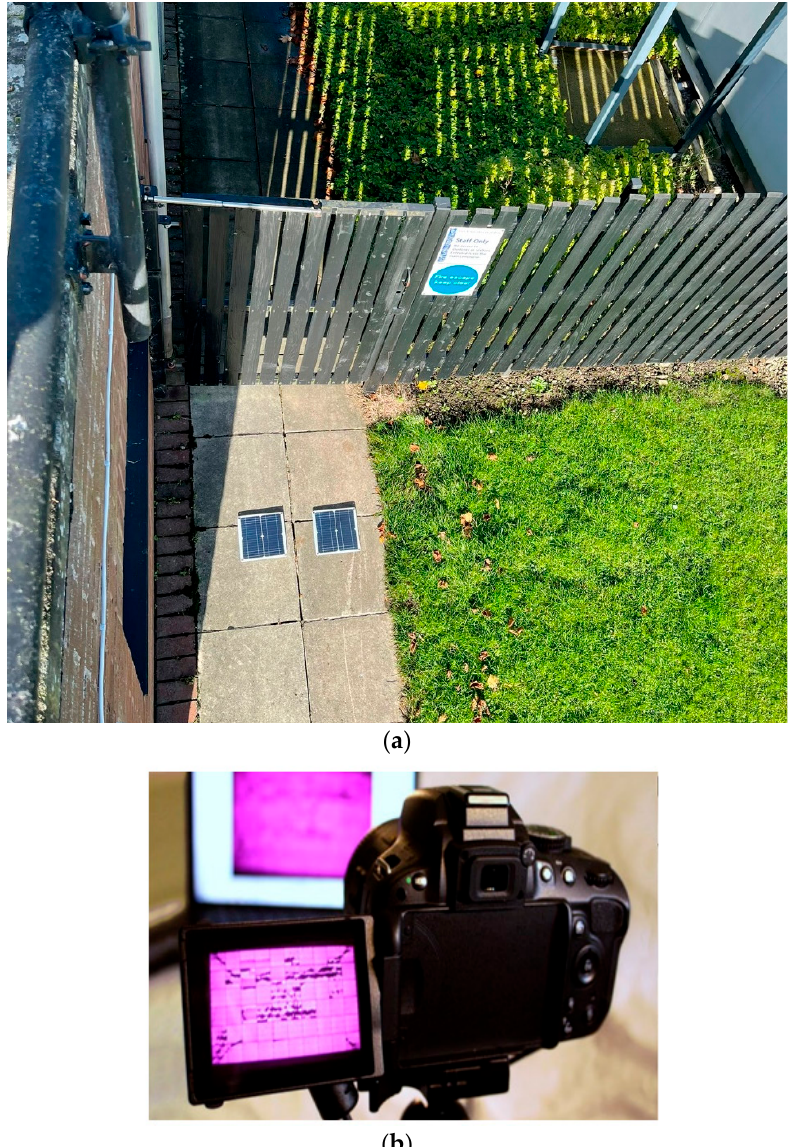
Figure 11. PV solar road tested in a public path at the University of York: ( a ) Picture of the solar panels, ( b ) EL imaging setup.